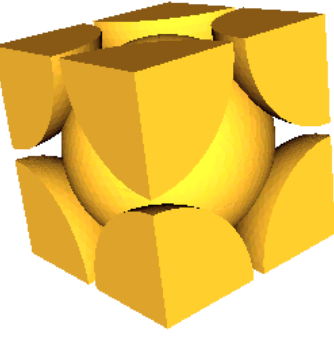
Figure 11. EPS cell with a face-centered cubic lattice.